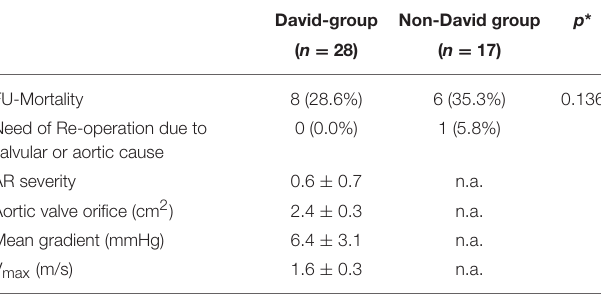
TABLE 4 | 5-year follow-up.